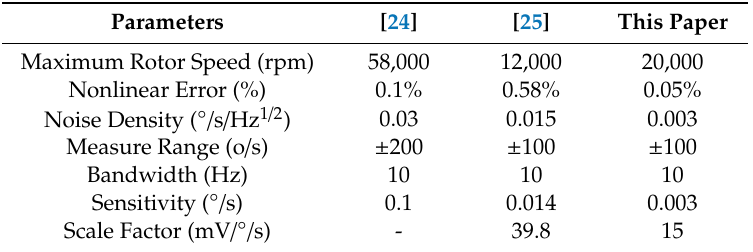
Table 4. Comparison of reported works with this